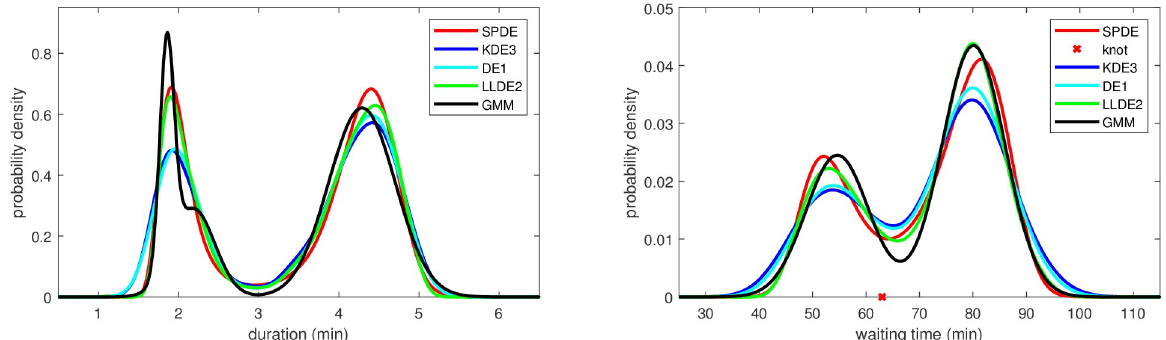
Fig 5. Old Faithful Geyser eruption data: Density estimates of the eruption duration (left) and waiting time (right) from various methods. For the duration data the SPDE is the model with potential function U ( y ) = α 1 log y + α 2 (1/ y ) + α 3 y + α 4 y 2 ; for the waiting time data it is the model SPL2 with 1 knot after knot